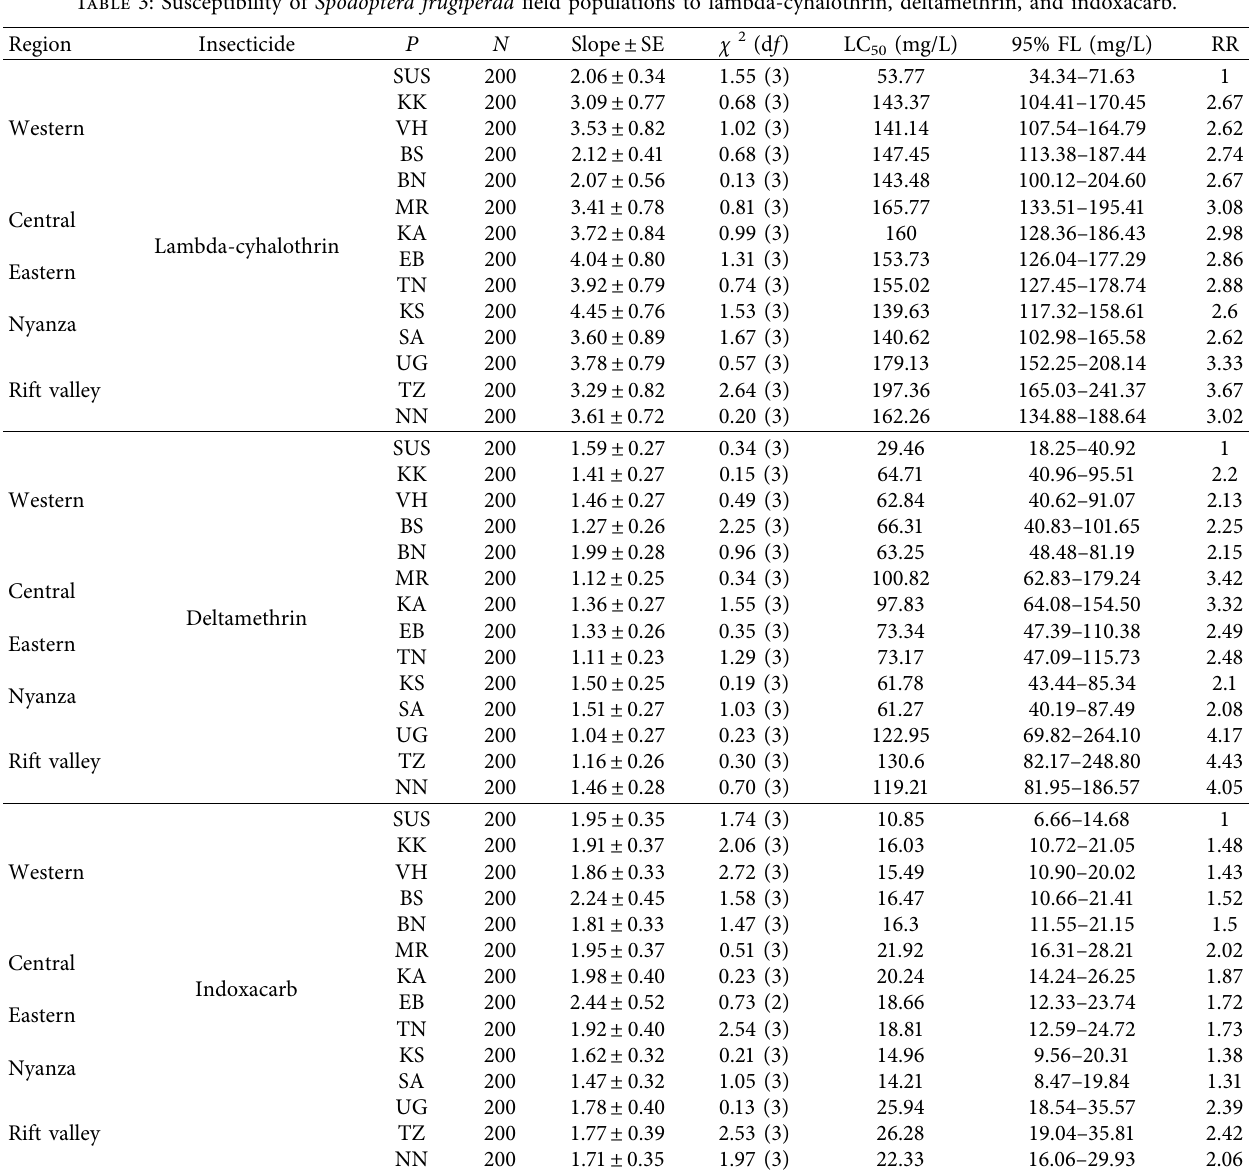
Table 3: Susceptibility of Spodoptera frugiperda field populations to lambda-cyhalothrin, deltamethrin, and indoxacarb. Region